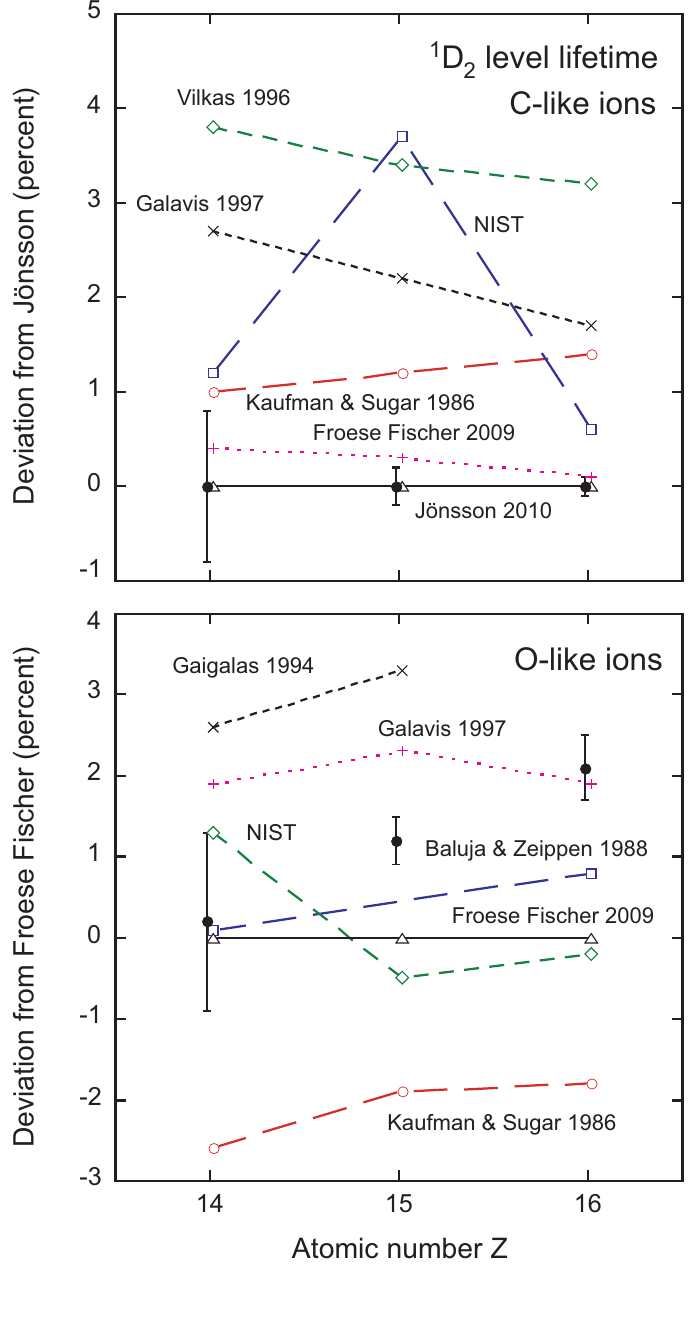
Figure 8. Lifetime of the 2s 2 2p 2 , 4 1 D level in C- and O-like ions of Si, P, and S. All 2 measurements (full markers with error bars) have been done at the TSR heavy-ion storage ring. The Si measurements could nowadays be redone with much higher statistical reliability, if the storage ring was still available. The data are shown relative to two computations. The computations shown scatter by a few percent around the experimental data, whereas some earlier computations differed by more than 10% (see